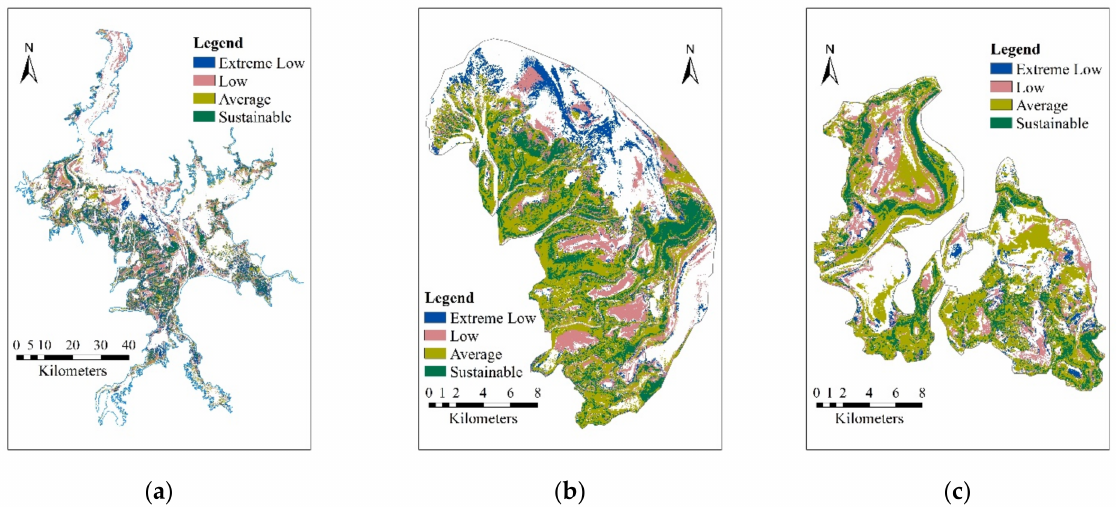
Figure 6. Sustainability of crane habitats in: ( a ) Poyang Lake wetland; ( b ) Nanjishan nature reserve; ( c ) Wucheng nature reserve.